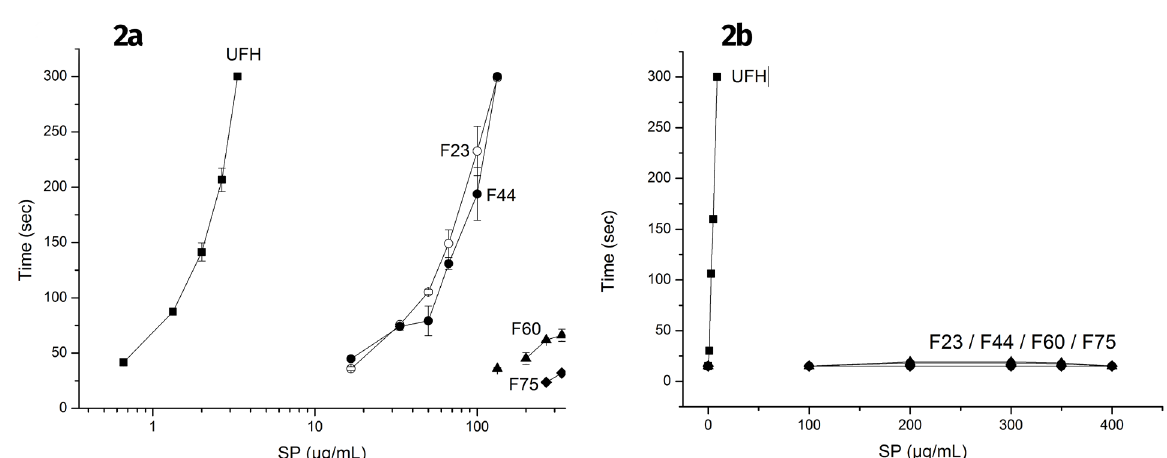
Figure 2. Anticoagulant activity of the precipitated SP fractions (F23, F44, F60 and F75) obtained from H. opuntia revealed by the APTT (2a) and PT (2b) assays. UFH – Unfractionated